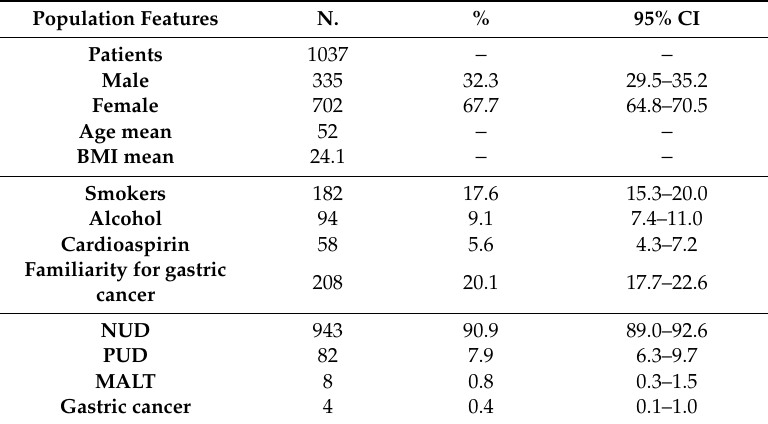
Table 1. Demographic and clinical characteristics of patients.